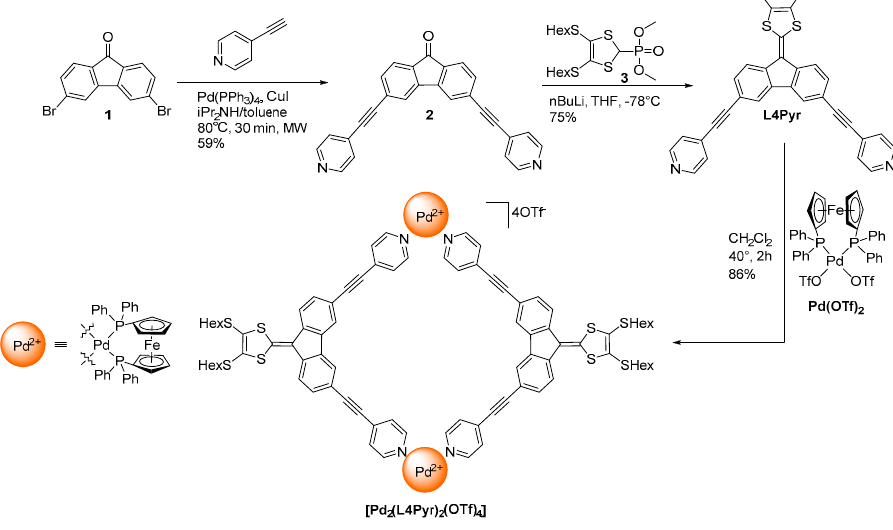
Figure 1. X-ray crystal structure of ligand L4Pyr